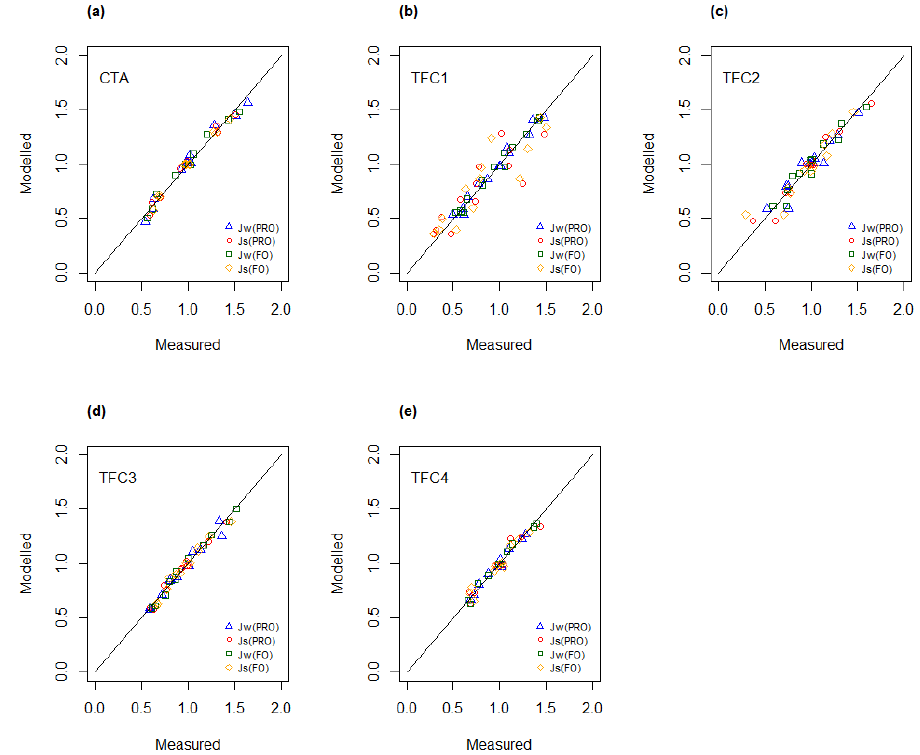
Figure 4. Linear regression modelled versus measured water and salt fluxes for ( a ) CTA; ( b ) TFC1; ( c ) TFC2; ( d ) TFC3 and ( e ) TFC4.